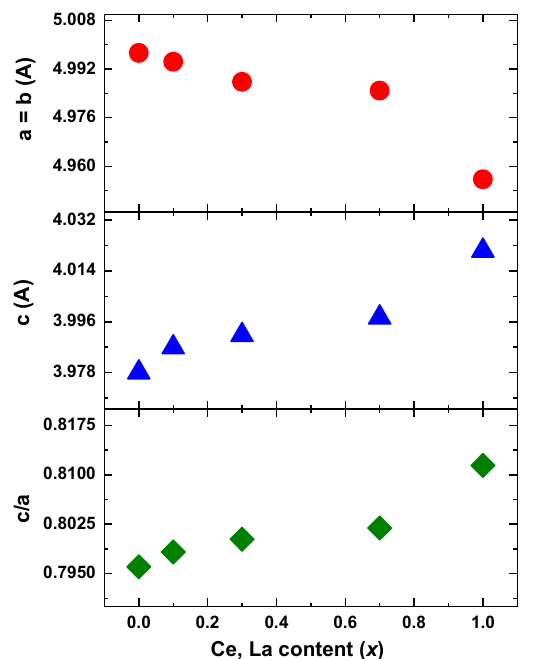
Figure 3. Unit Cell parameters for Sm 1 − x (Ce 0.75 La 0.25 ) x Co 5 (x = 0.1–1.0) compounds.